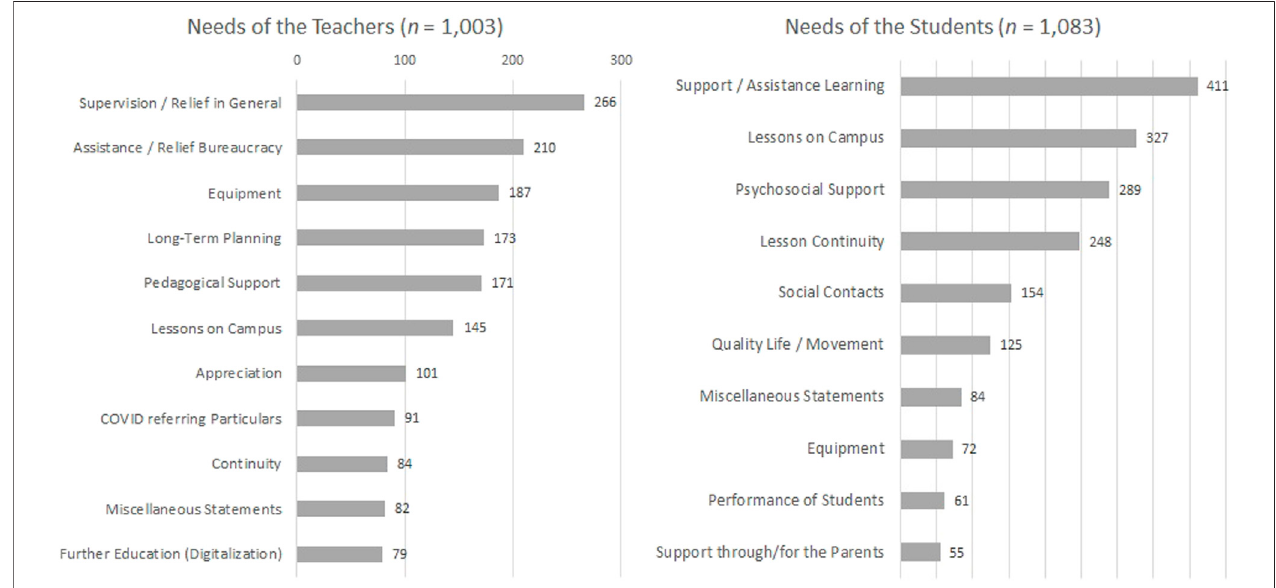
FIGURE 3 | Need for support of teachers and